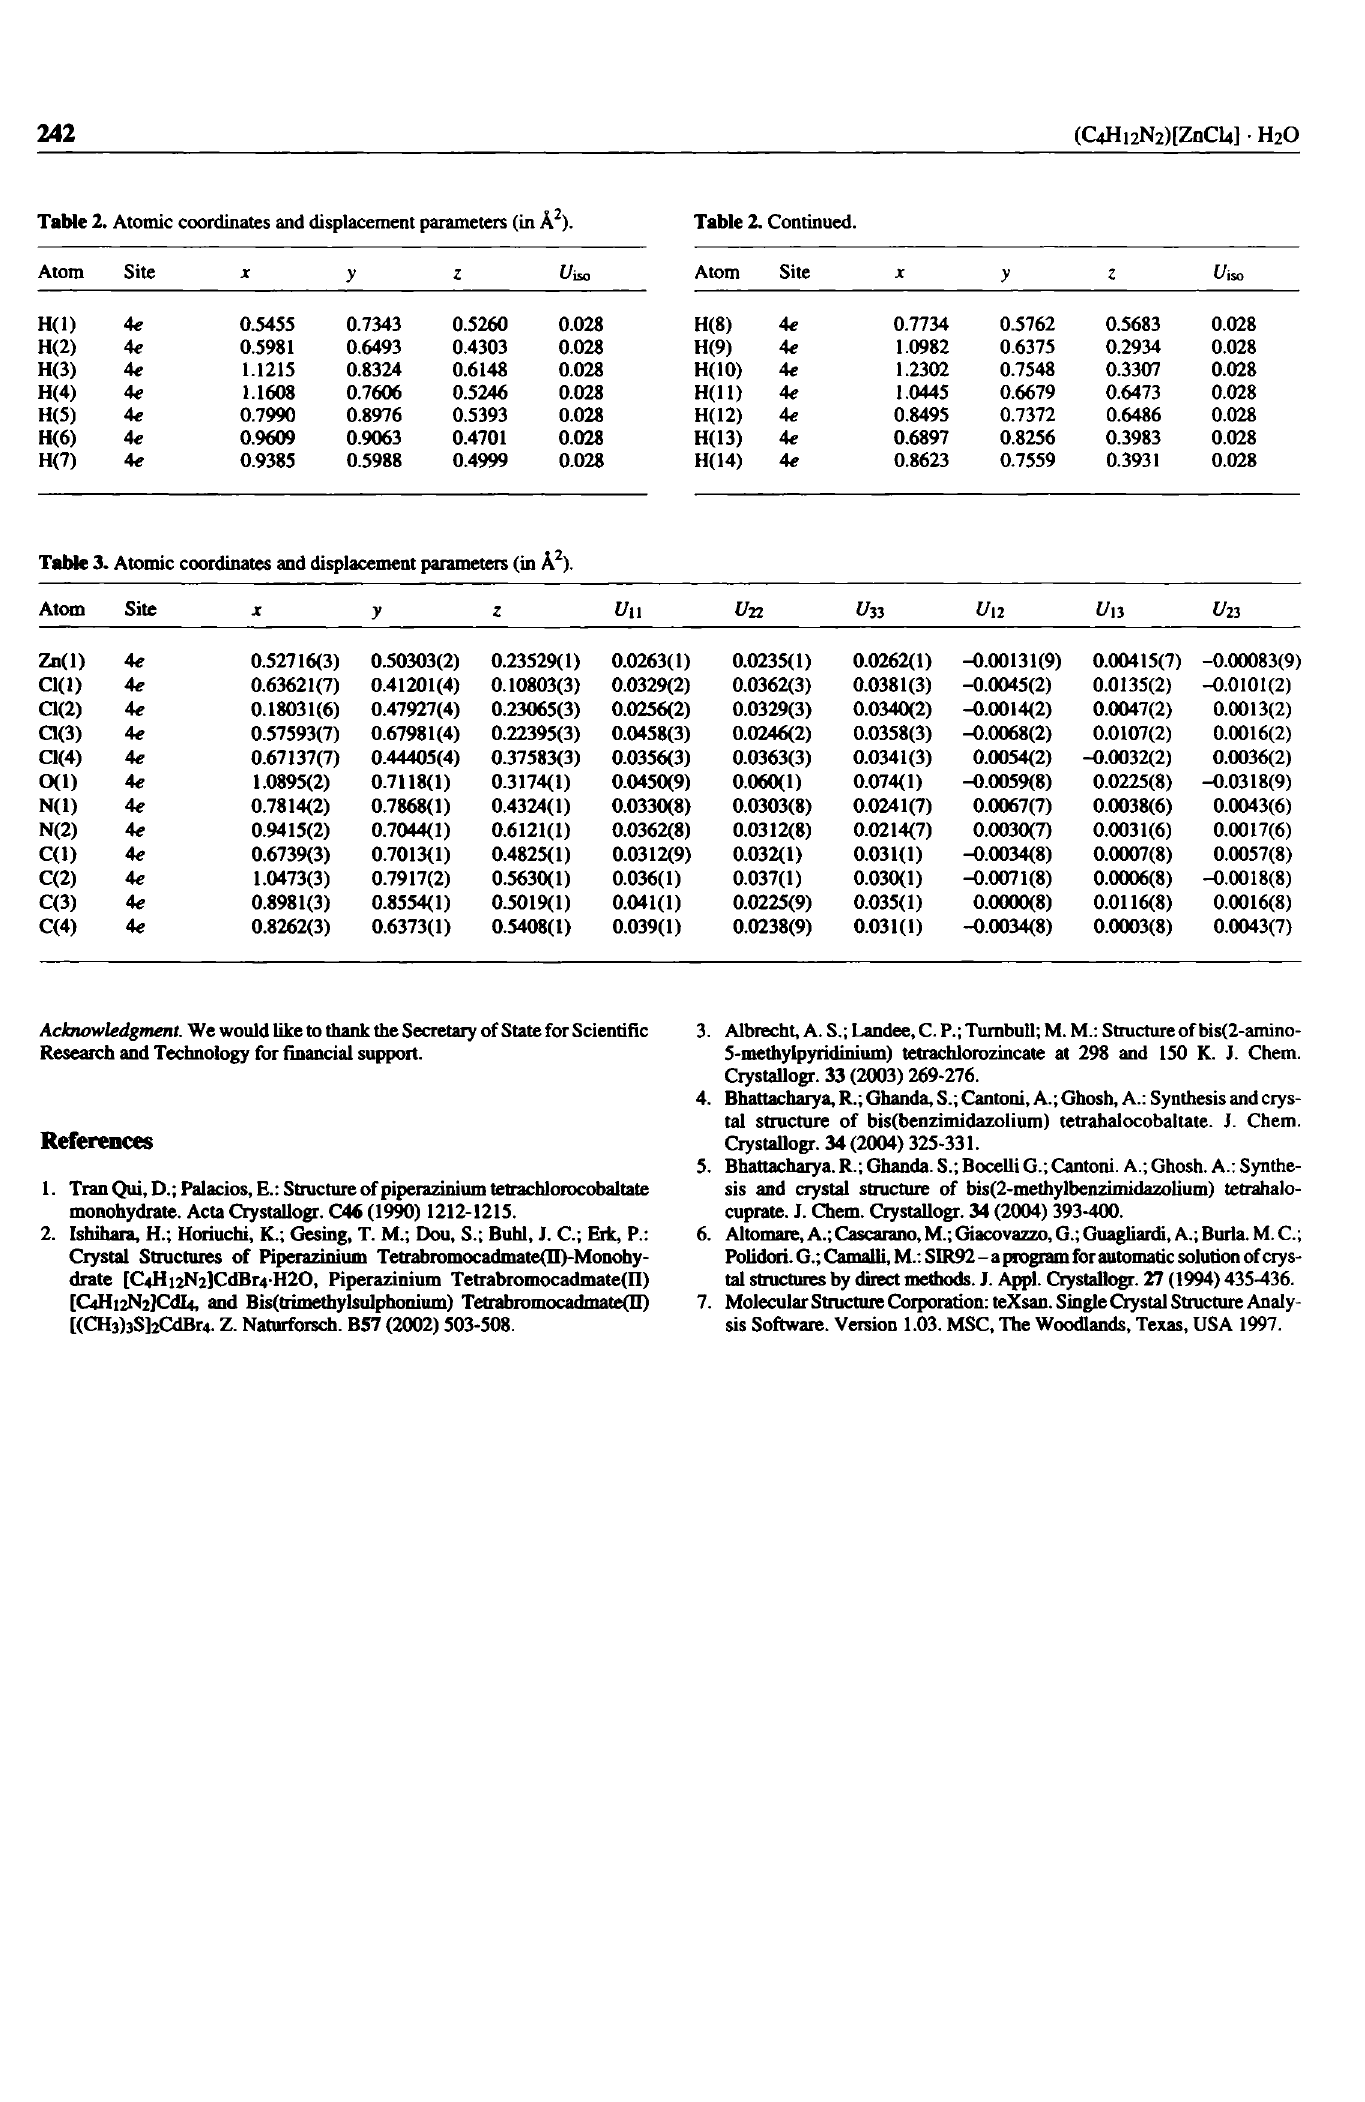
Table 3. Atomic coordinates and displacement parameters (in A 2